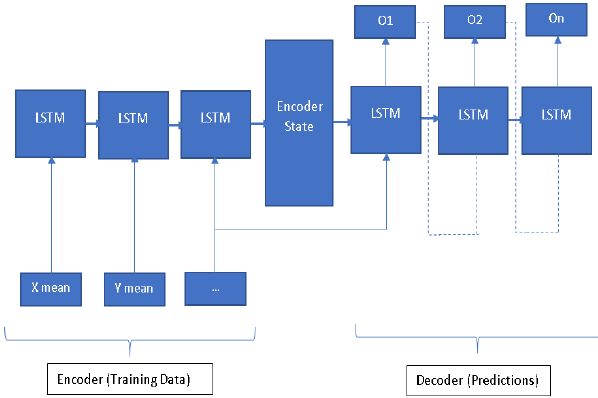
Figure 2. Structure of the